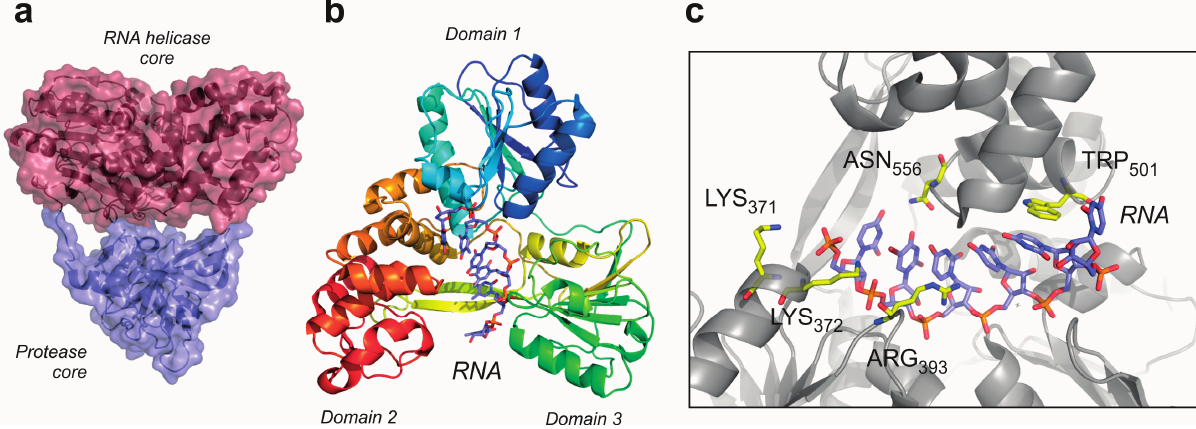
Figure 6. Structural features of viral RNA helicases from the Flaviviridae family, exemplified by the structure of the NS3 bifunctional protease-RNA helicase from human hepatitis C virus (HCV). ( a ) Overall structure of the bifunctional NS3 protein, showing the location of the protease and helicase cores (PDB code: 4A92); ( b ) Structure of the RNA helicase core from the HCV NS3 protein in complex with a synthetic RNA oligonucleotide (PDB code 3KQK); and ( c ) Detail of the residues involved in the interaction with RNA in the HCV NS3 helicase core. Note the presence of positively charged residues (Lys 371 , Lys 372 and Arg 393 ) interacting with the phosphate backbone of the RNA